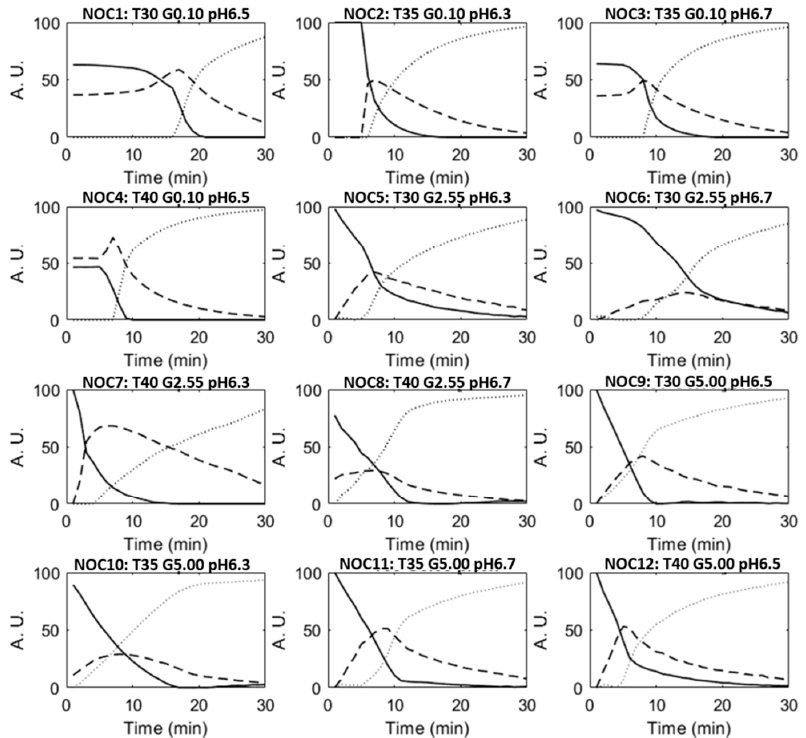
Figure 3. MCR-ALS concentration profiles of the milk renneting batches developed under normal operating conditions (NOC 1 -NOC 12 ). Solid lines describe the liquid-like behavior of milk, dashed lines represent the transition phase of renneting, and dotted lines reflect the solid-like behavior of coagulated milk. See Table 1 for sample identification.